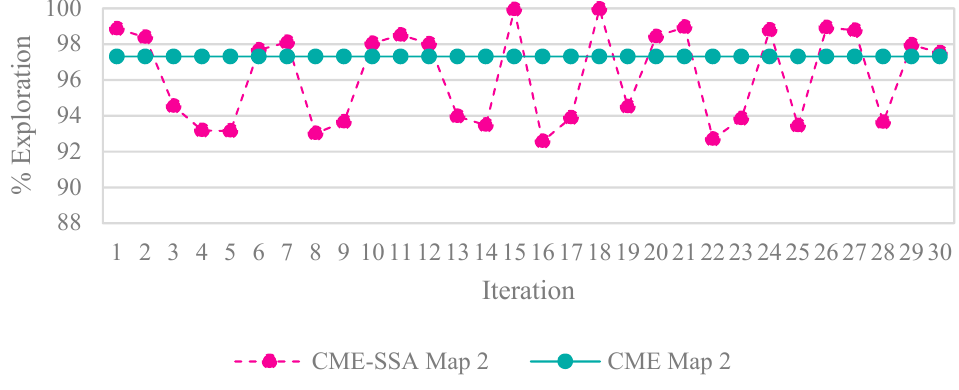
Figure 4. Percentage of exploration per iteration for CME-SSA and CME.